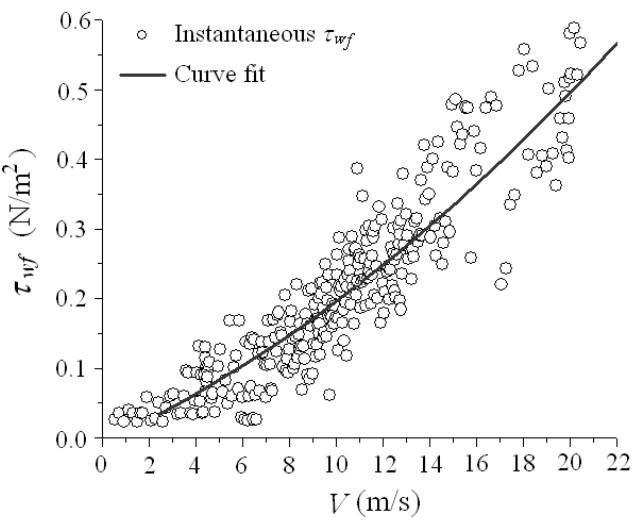
Figure 6. Instantaneous τ wf measured on the first carriage and the second order polynomial curve fit in the recirculation mode.